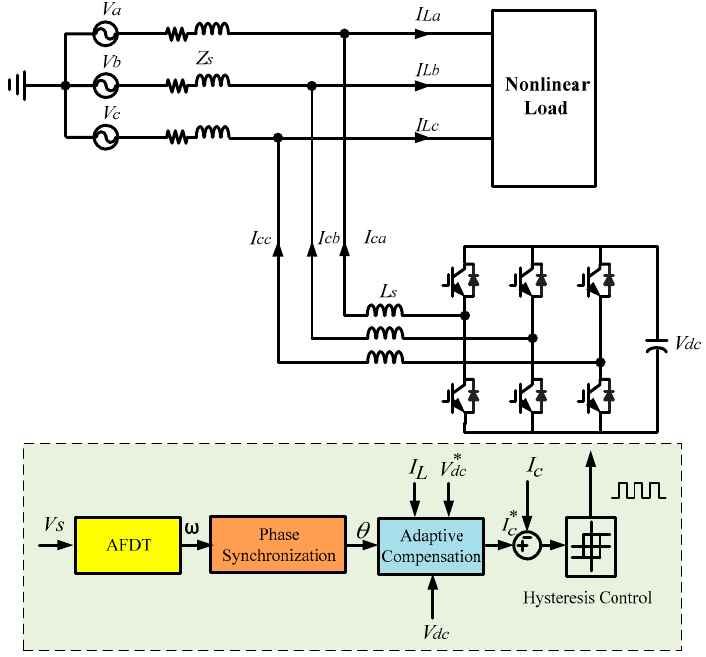
Figure 1. Proposed adaptive frequency-based reference compensation current-control strategy.